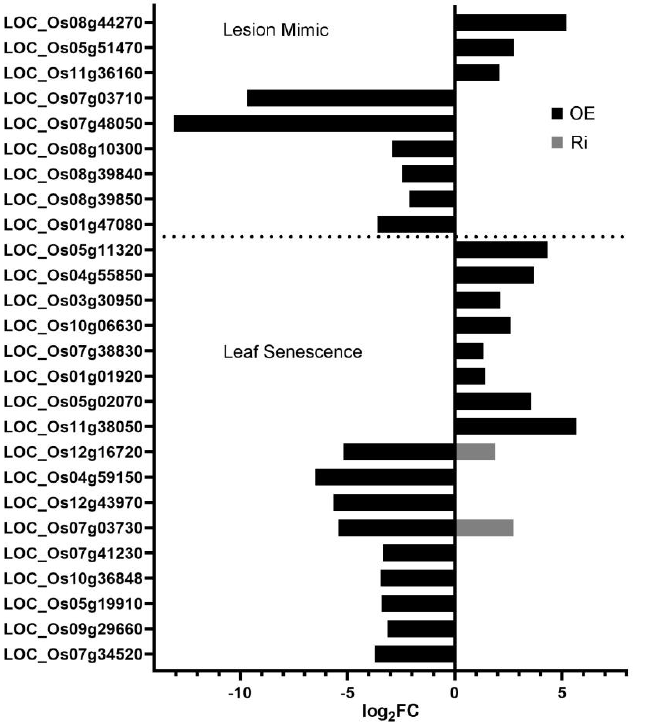
Figure 4. Differentially enriched genes in the lesion mimic and leaf senescence pathways. OE indi- cates the overexpression line, Ri indicates the RNA interference line, abscissa indicates a log2 fold change, and ordinate indicates the locus name of the gene.